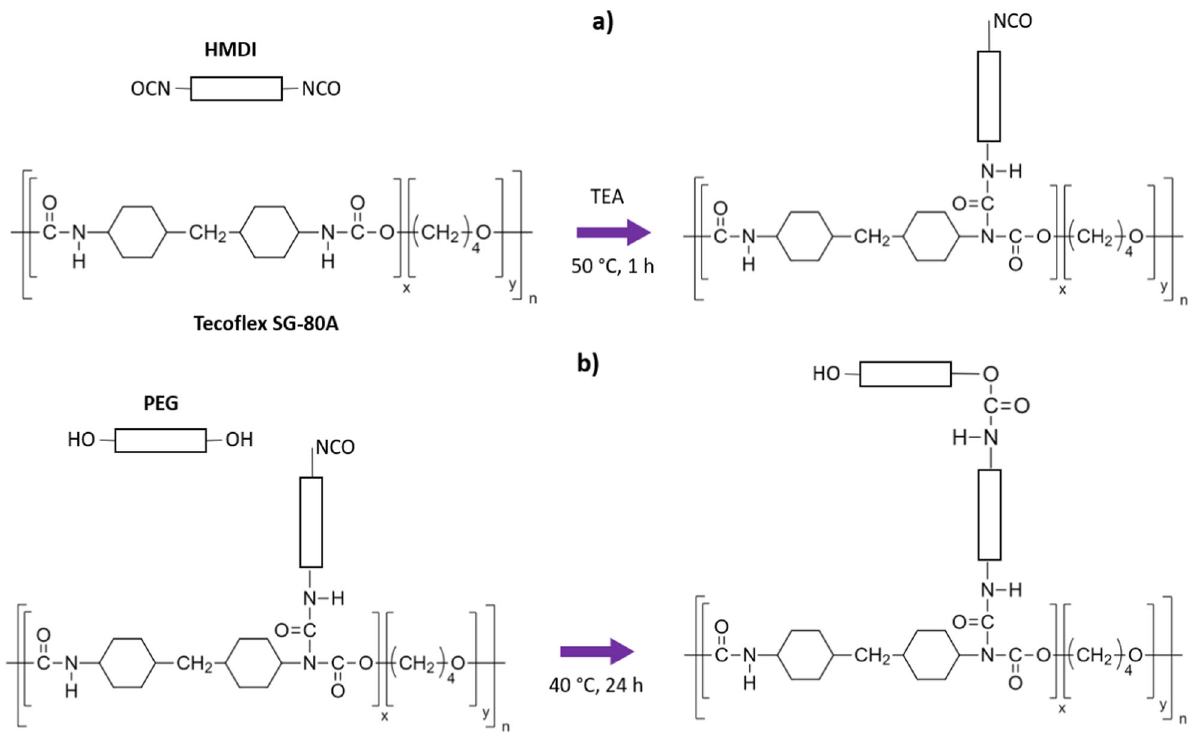
Fig. 1 Grafting reaction of PEG onto PU substrata. ( a ) One isocyanate group from end groups of HMDI reacts with the secondary amine of the urethane group to yield allophanate linkages remaining an